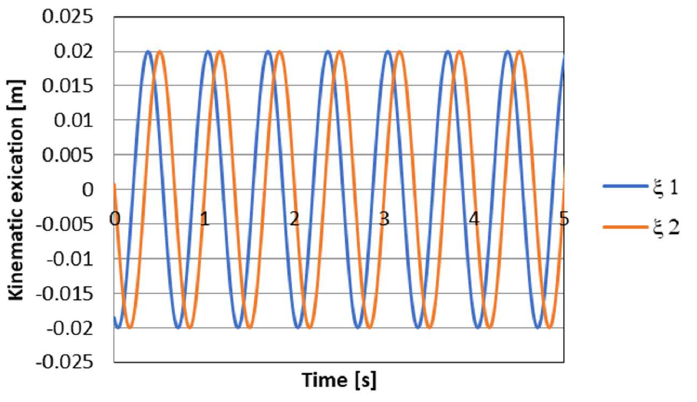
Figure 11. Model of vehicle and semi-active suspension: m—mass of body, J y – inertia of body, z— transfer axis, Φ y —angle rotation of body, V—velocity of a vehicle, a 1 , a 2 —distance from the center of gravity of the front axle (1), the rear axle (2), k 1 , k 2 —spring stiffness of the front suspension wheel (1), rear suspension wheel (2), c 1 , c 2 —damping coefficient in the front wheel suspension (1), the rear wheel suspension (2), 𝜉 1 , 𝜉 2 —kinematic excitation of the front wheel (1), the rear wheel (2). Figure 13. Course of kinematic excitation, respectively 𝜉 (cid:2869) —front wheel, 𝜉 (cid:2870) —rear wheel.